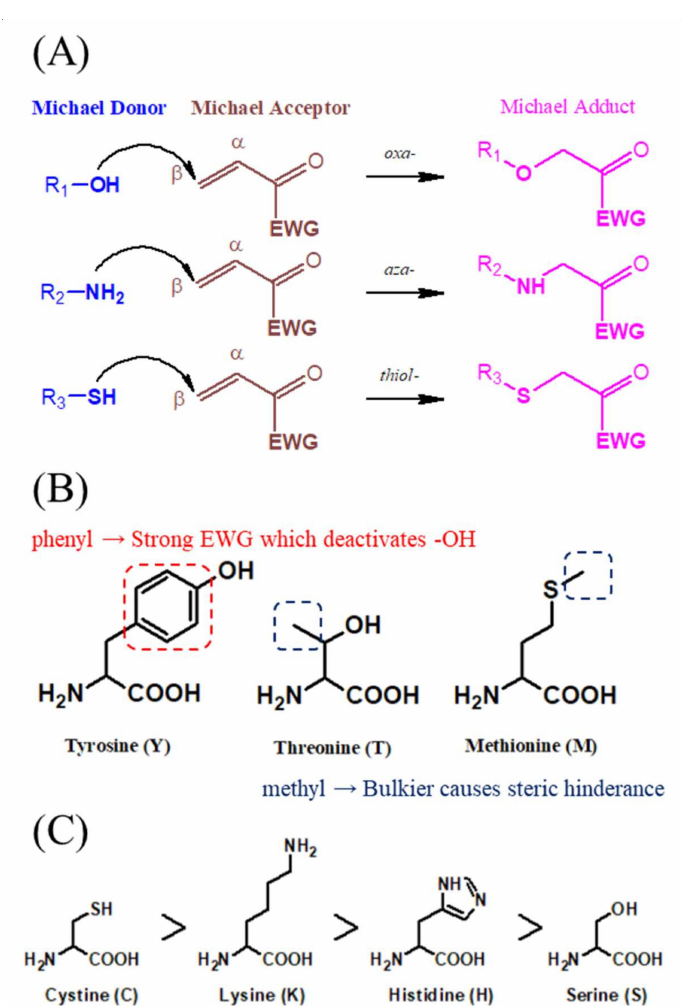
Figure 1. Michael addition reaction with amino acids in living organism. ( A ) Michael addition is a chemical reaction wherein a nucleophile attacks the β -carbon of an α , β -unsaturated carbonyl compound. In living organisms, the reaction is mainly classified into oxa-, aza-, and thiol-Michael additions based on the reactive site of the nucleophile being a hydroxyl, amine, and thiol group, respectively. ( B ) Amino acids are not considered to be Michael donors because of functional groups that cause steric hindrance (blue dotted line) and deactivating groups (red dotted line) ( C ) The order of reactivity preference of known amino acids as Michael